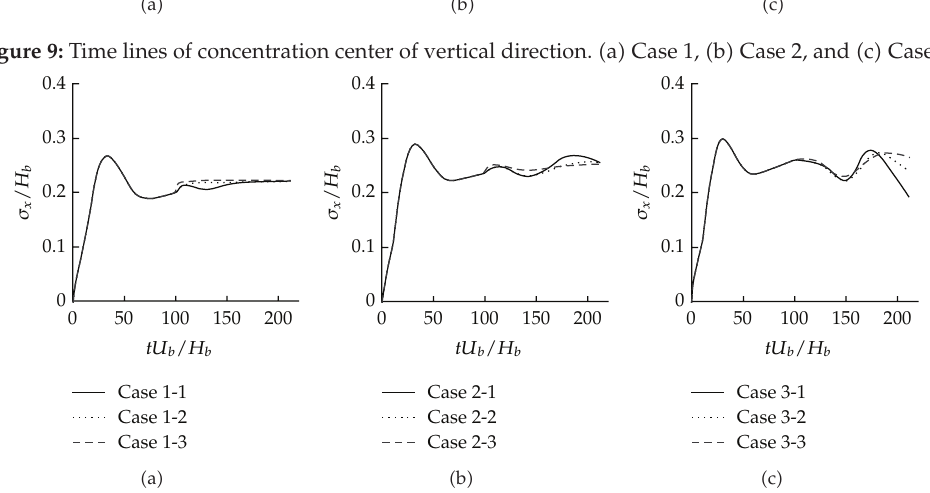
Figure 10: Time lines of concentration dispersion width of streamwise direction (cid:3) a (cid:4) Case 1, (cid:3) b (cid:4) Case 2, and (cid:3) c (cid:4) Case